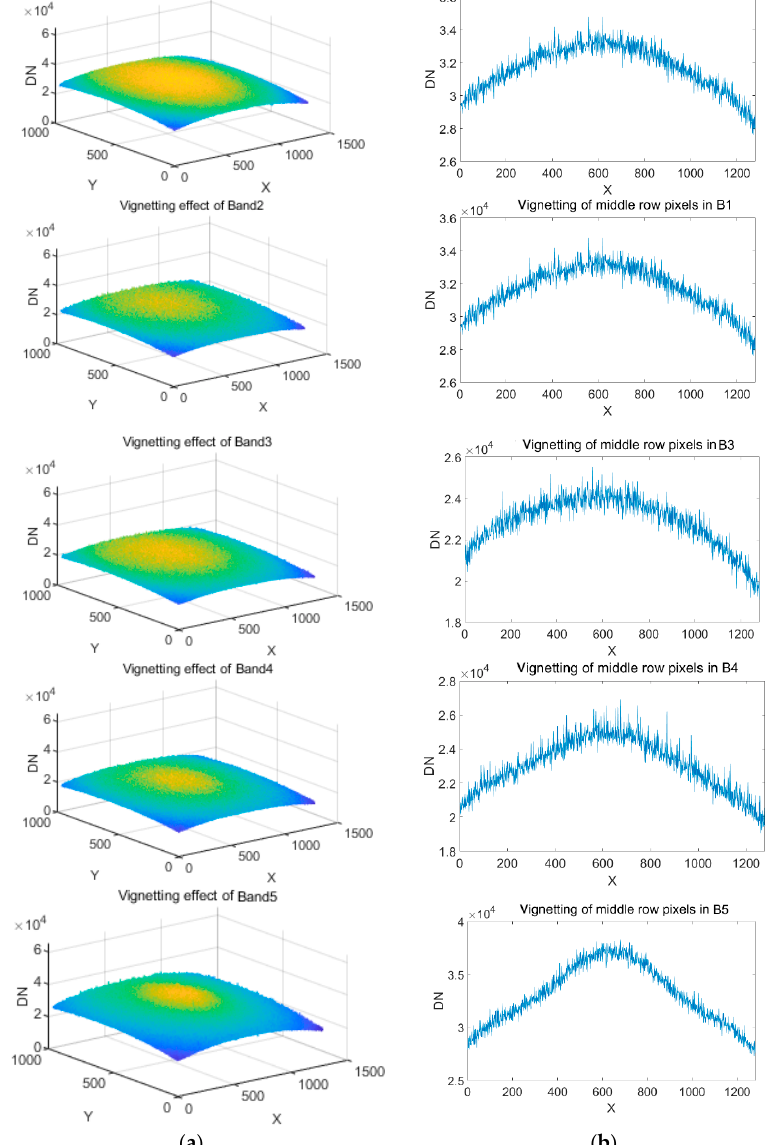
Figure 10. Vignetting effect: ( a ) vignetting of images of Band1-Band5; ( b ) vignetting of middle row pixels in the images of Band1–Band5.